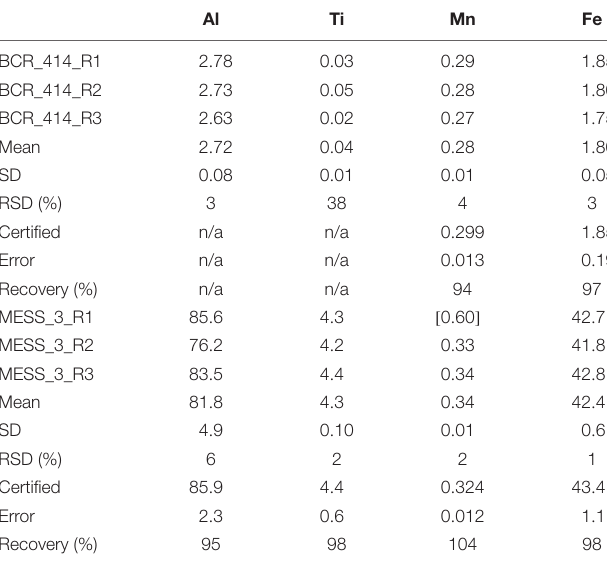
TABLE 4 | Results of the analysis of certified reference materials BCR_414 (freshwater plankton) for trace elements and MESS_3 marine sediment reference material for trace elements.